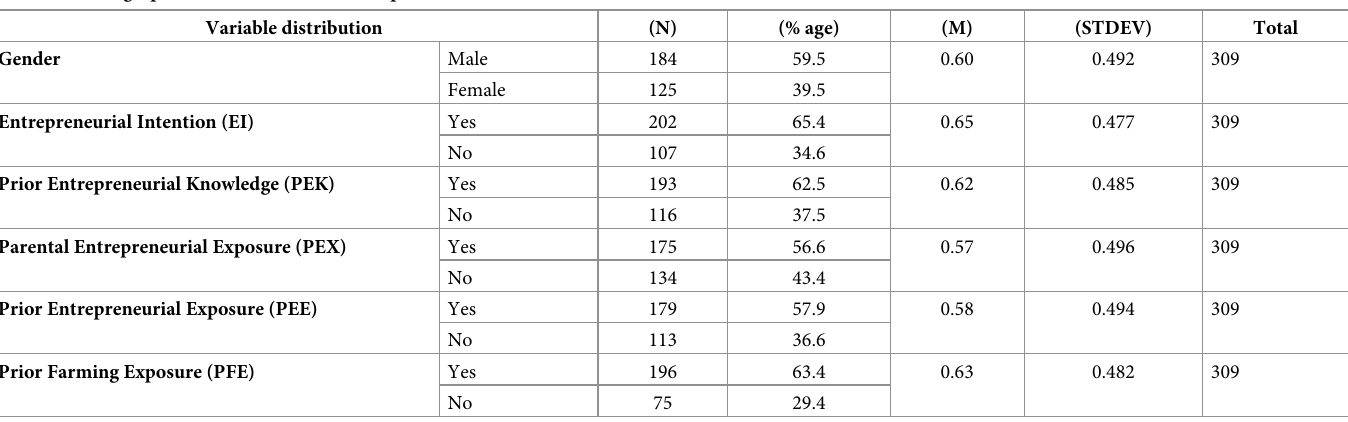
Table 1. Demographic characteristics of the respondents. Variable